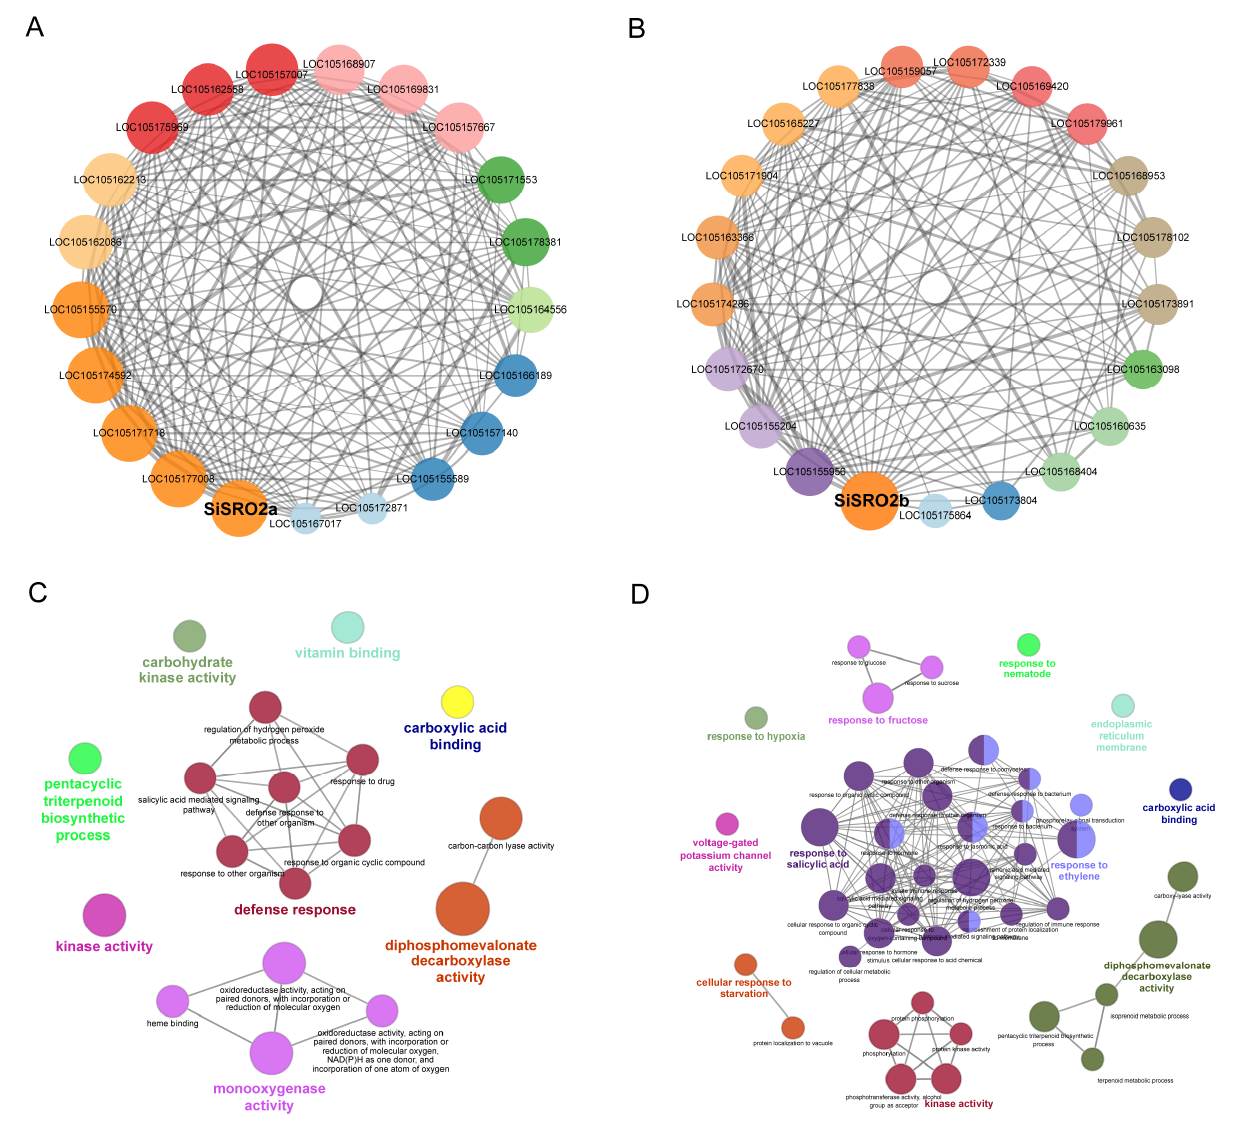
Figure 9. Co-expression analysis of SiSROs under abiotic stress. The co-expression network of SiSRO2a ( A ) and SiSRO2b ( B ). The co-expression neighbourhood of SiSROs was analyzed by mutual rank (MR)-based co-expression analysis based on transcriptomic data of sesame under various abiotic stresses. The 20 highly co-expressed genes with the smallest MR value are shown. GO enrichment of the co-expressed genes of SiSRO2a ( C ) and SiSRO2b ( D ). Functionally grouped network was generated in ClueGO with GO terms as nodes linked based on their kappa score level ( ≥ 0.3). Colors reflect the label of the most significant term per group. The node size represents the term enrichment